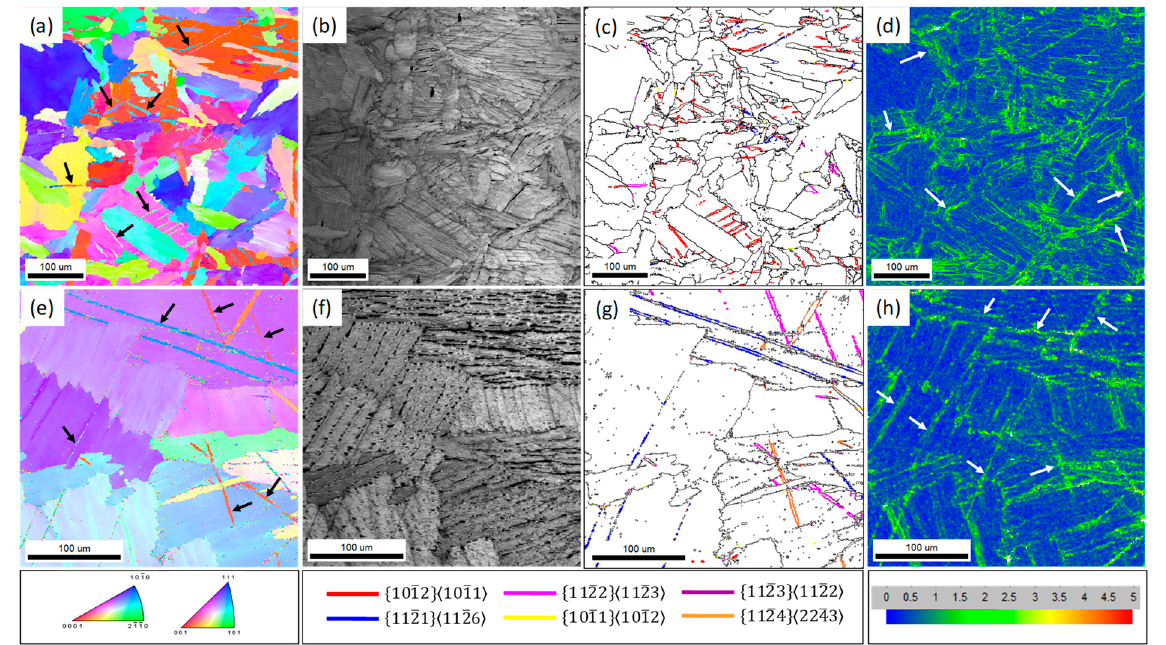
Figure 7. EBSD maps of MG Ti ( a – d ) and CG Ti ( e – h ) sample, about 2 mm away from the impact fracture surface. ( a , e ) are the inverse pole figure (IPF), ( b , f ) are image quality (IQ), ( c , g ) are the grain boundary (GB) map, and the six twinning systems are outlined in different colors, ( d , h ) are the local average misorientation (LAM) map.